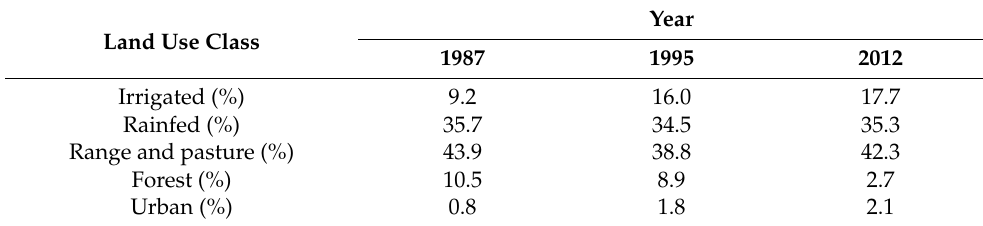
Table 8. Land use classes (total) percentage in different